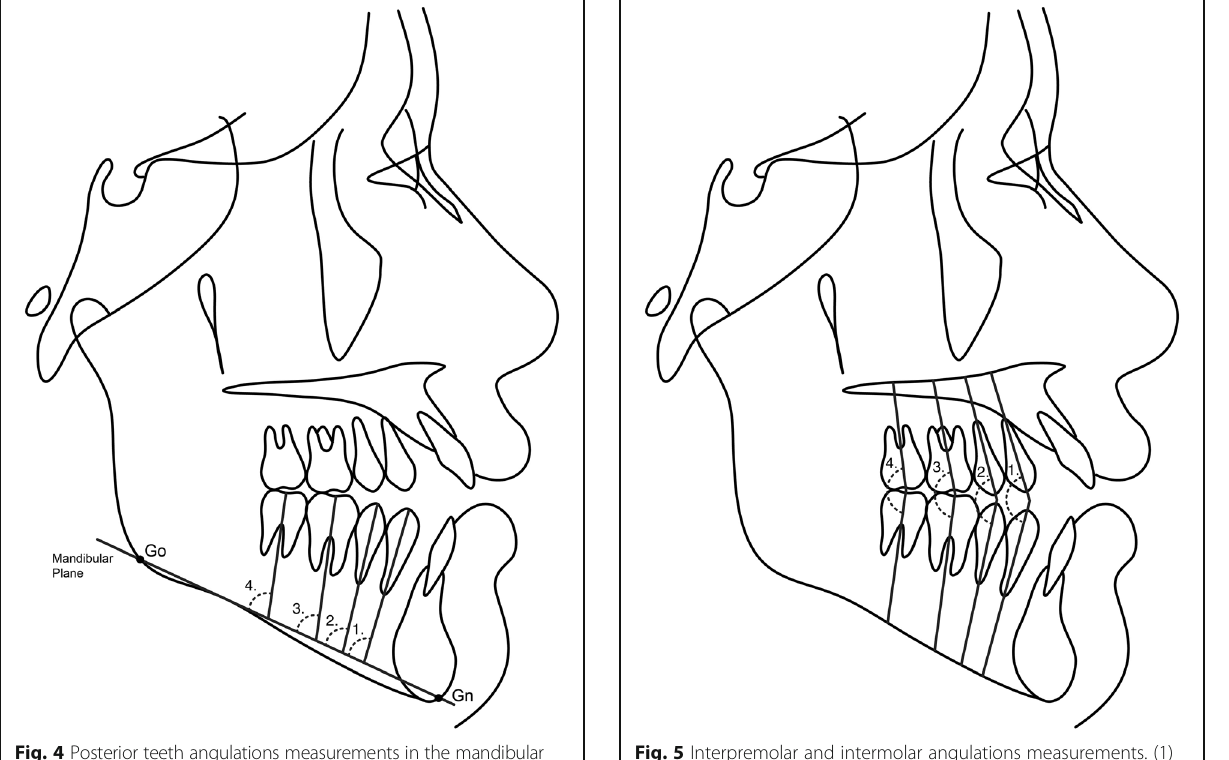
Fig. 5 Interpremolar and intermolar angulations measurements. (1) Mx4.Md4 (°) — long axis (apex to tip) of maxillary and mandibular 1st premolars; (2) Mx5.Md5 (°) — long axis (apex to tip) of maxillary and mandibular 2nd premolars; (3) Mx6.Md6 (°) — long axis (furcation to